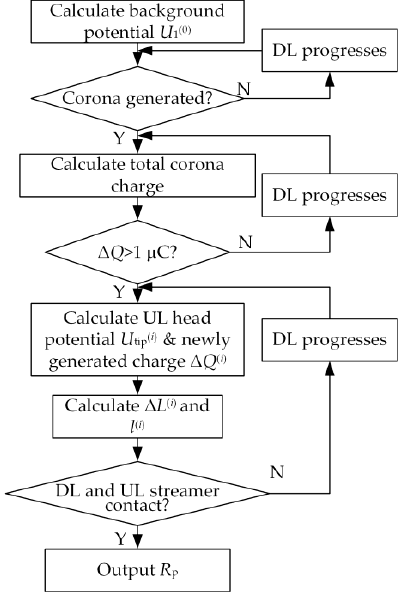
Figure 5. Flowchart of the calculation for the striking distance of the tip receptor, R p .